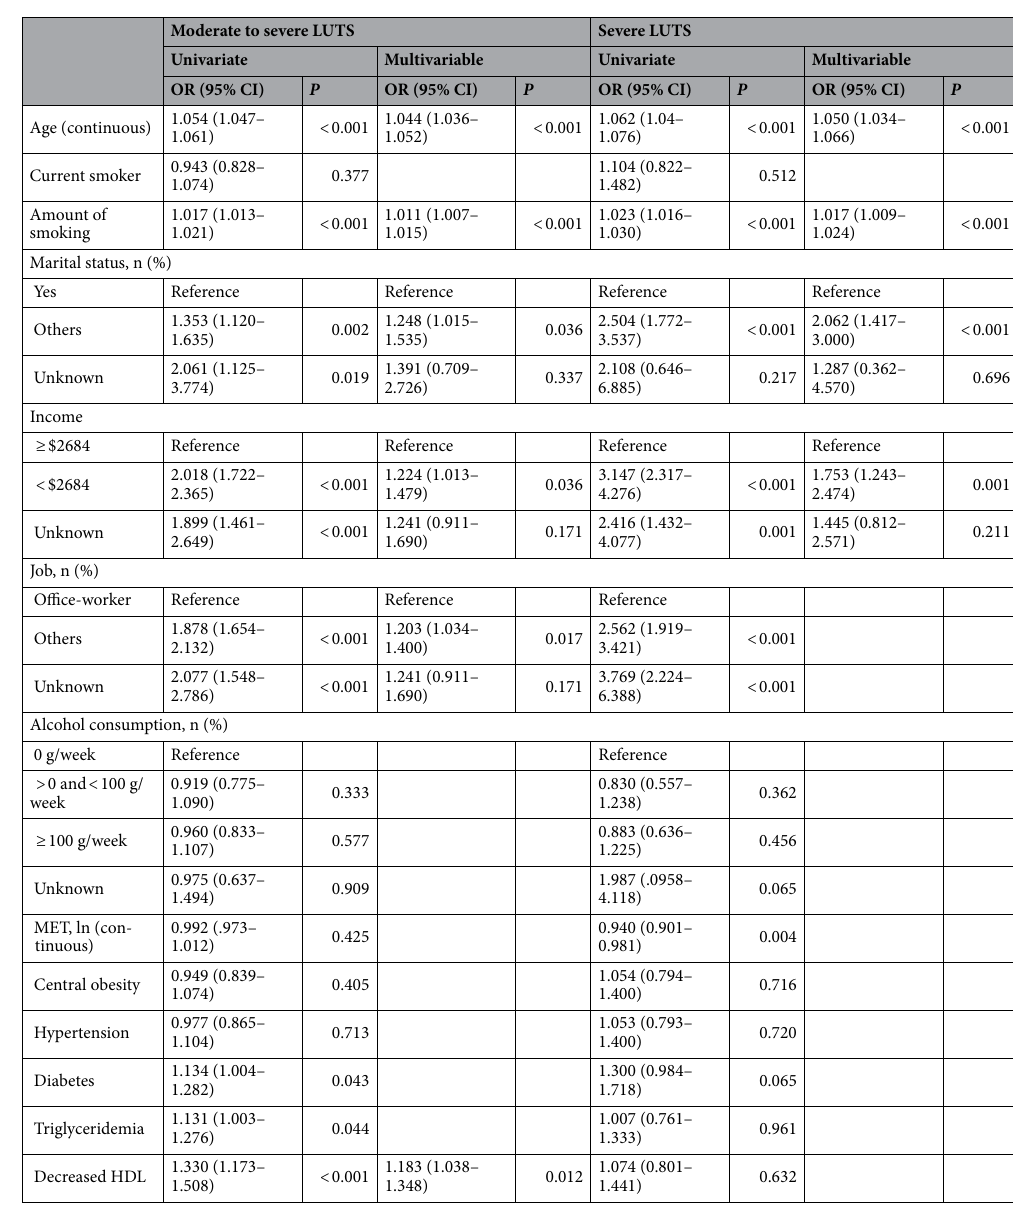
Table 3. Variables associated with the severity of LUTS.